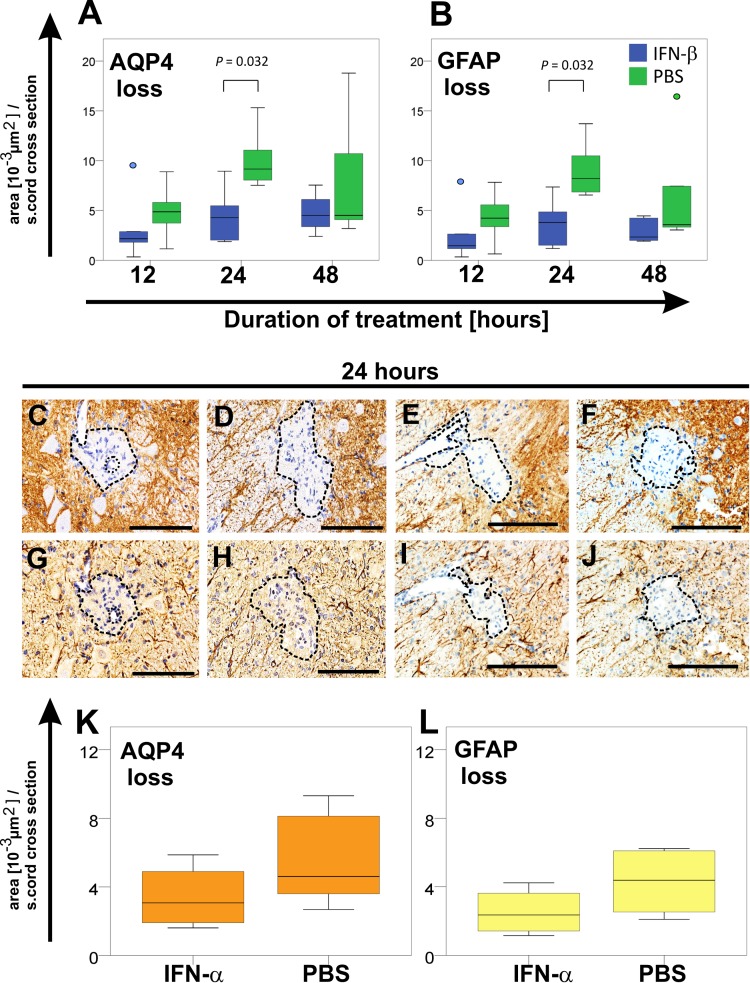
Differences in tissue damage between type I interferon-treated animals with ENMO.Size determinations of lesions with loss of AQP4 (A) or GFAP (B) reactivity in spinal cord sections of ENMO animals treated with IFN-β (blue) or PBS as vehicle control (green) for 12, 24, or 48 hours. Shown here are median and range of 5 animals per group. Differences between IFN-β and PBS-treated animals were significant after a 24-hour treatment with IFN-β (p = 0.032, Mann-Whitney U test; The blue and green dots indicate outliers). Shown in C-J are representative spinal cord sections reacted with antibodies against AQP4 (C-F, brown) or GFAP (G-J, brown) of animals treated for 24 hours with IFN-β (C,G) or PBS (D, H), and with IFN-α (E,I) or PBS (F,J). Counterstaining was done with hematoxylin to reveal nuclei (blue).